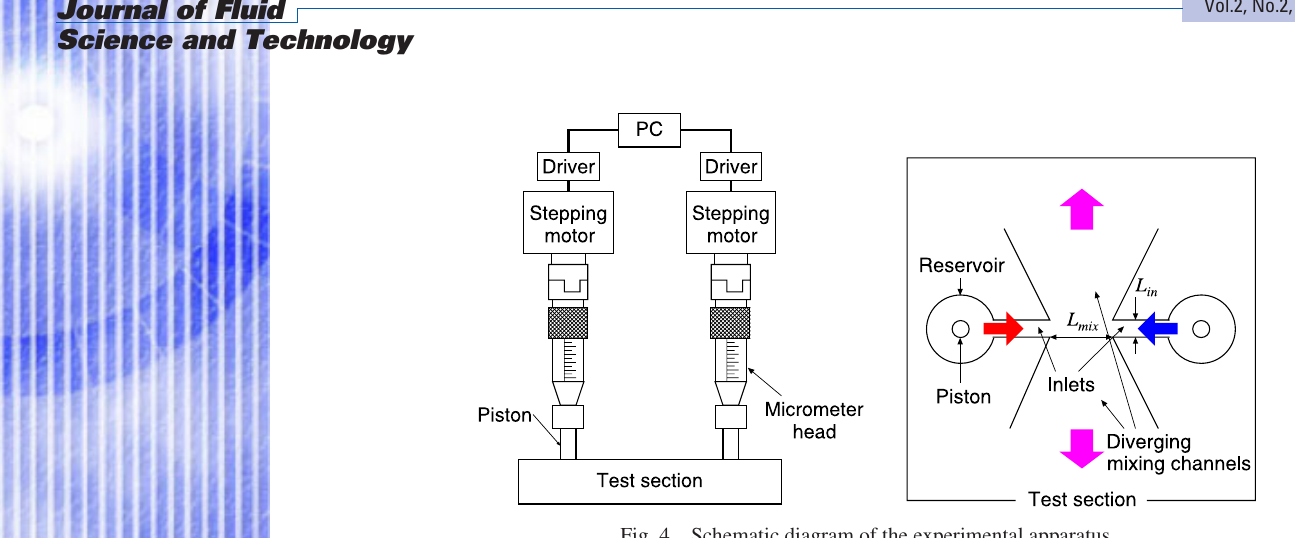
Fig. 4 Schematic diagram of the experimental